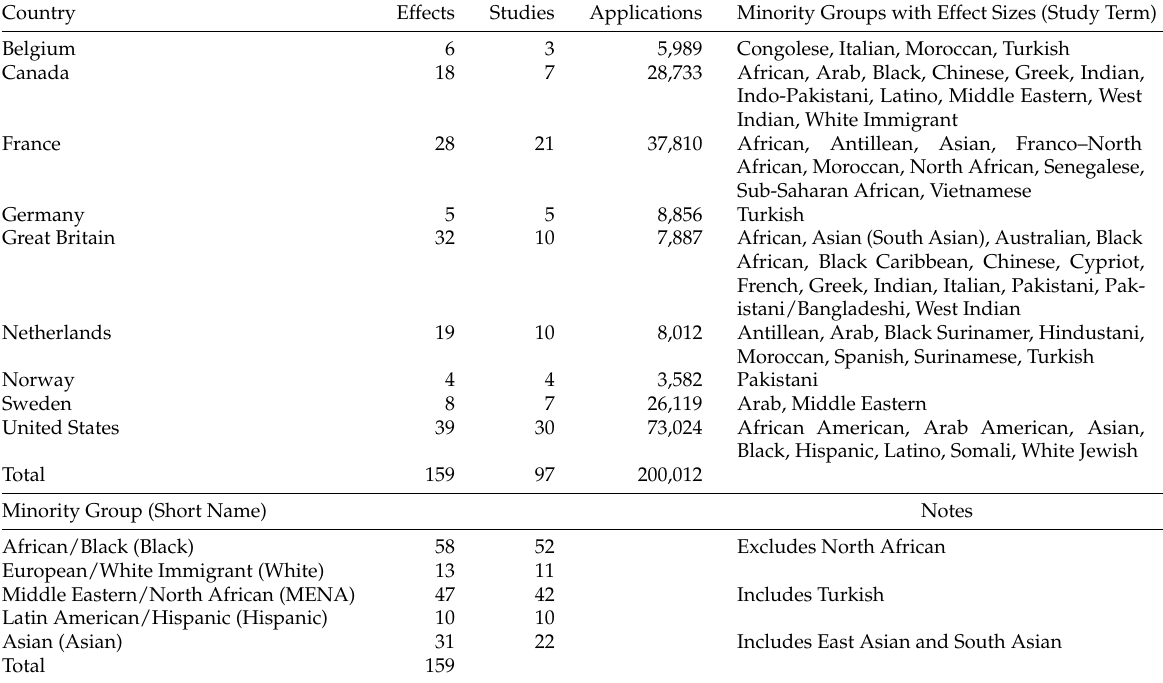
Table 1: Number of effects and studies by country and minority groups.